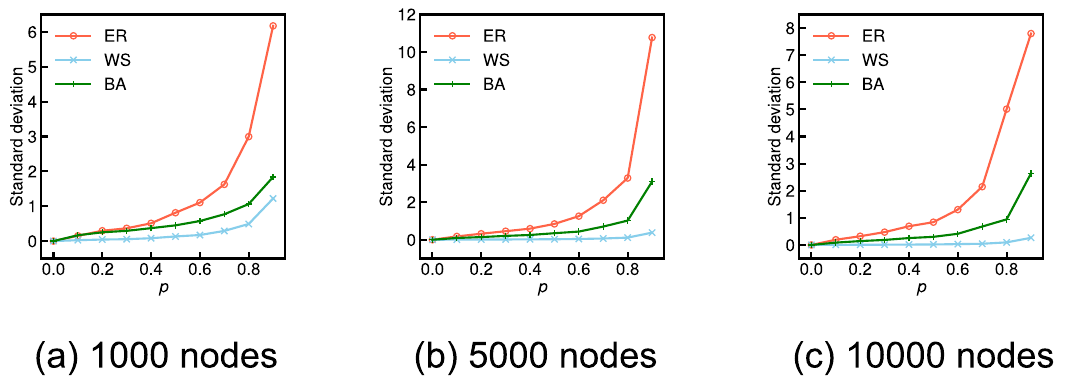
Figure 3. Comparison of the standard deviation of the relative global clustering coefficients across 100 independent sets of randomly missing nodes with the probability p on ER, WS, and BA graphs for each 1000, 5000, and 10,000